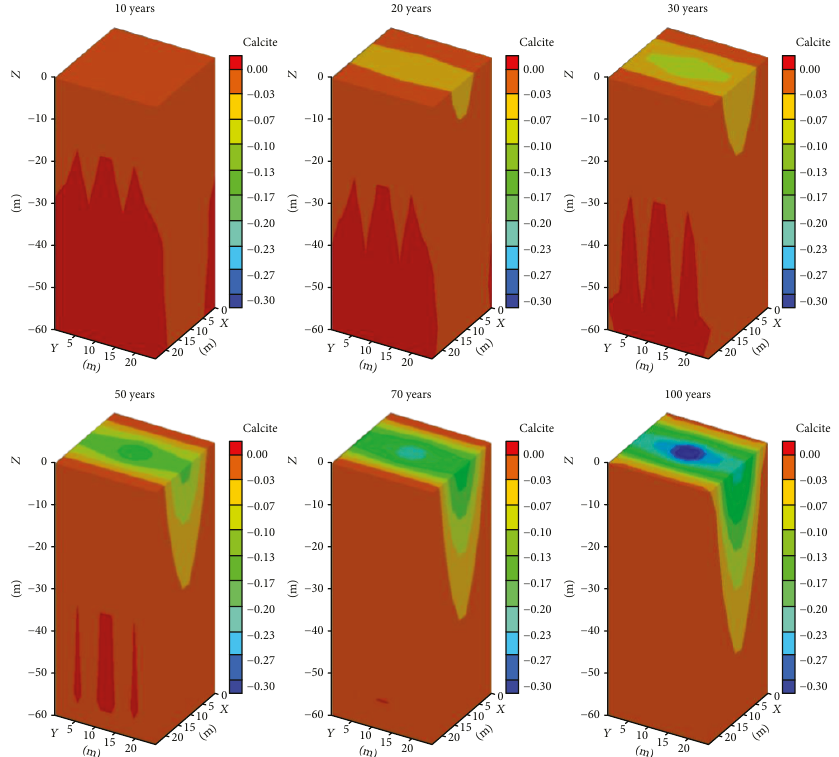
Figure 7: The corrosion range of the fi ssure under medium hydrodynamic conditions-medium permeability — 10 °